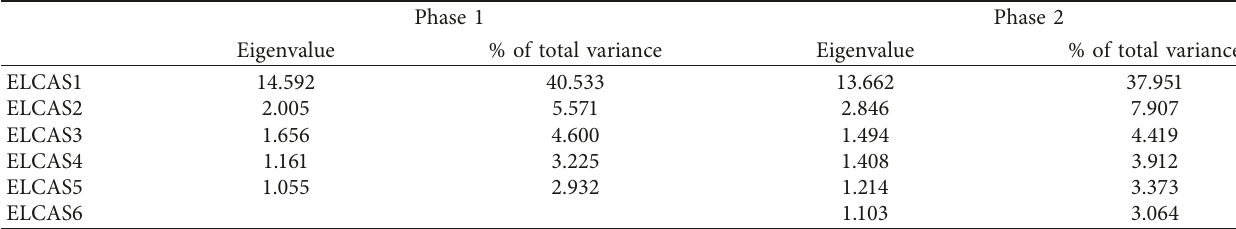
Table 3: Eigenvalues and explained variances of ELCAS factors.